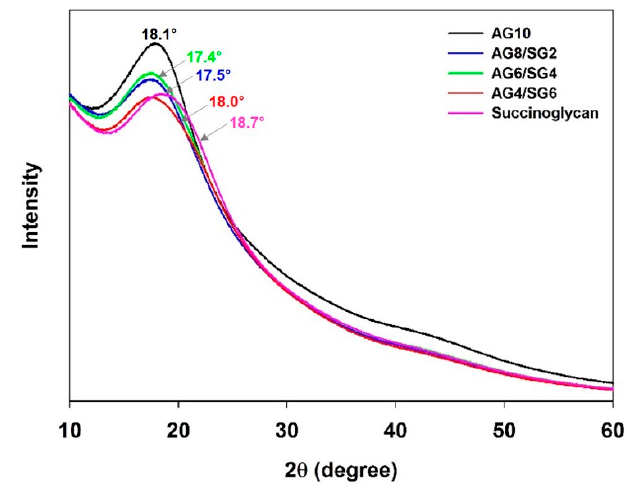
Figure 5. Changes in XRD patterns due to agarose/succinoglycan hydrogel formation by addition of succinoglycan.